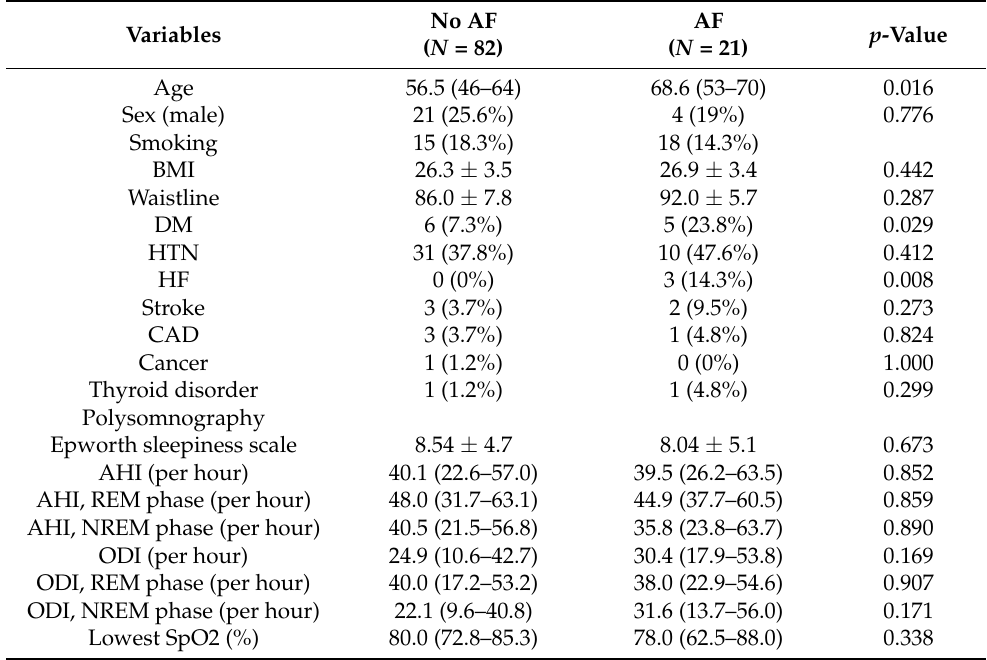
Table 1. Baseline characteristics of obstructive sleep apnea syndrome patients with and without atrial